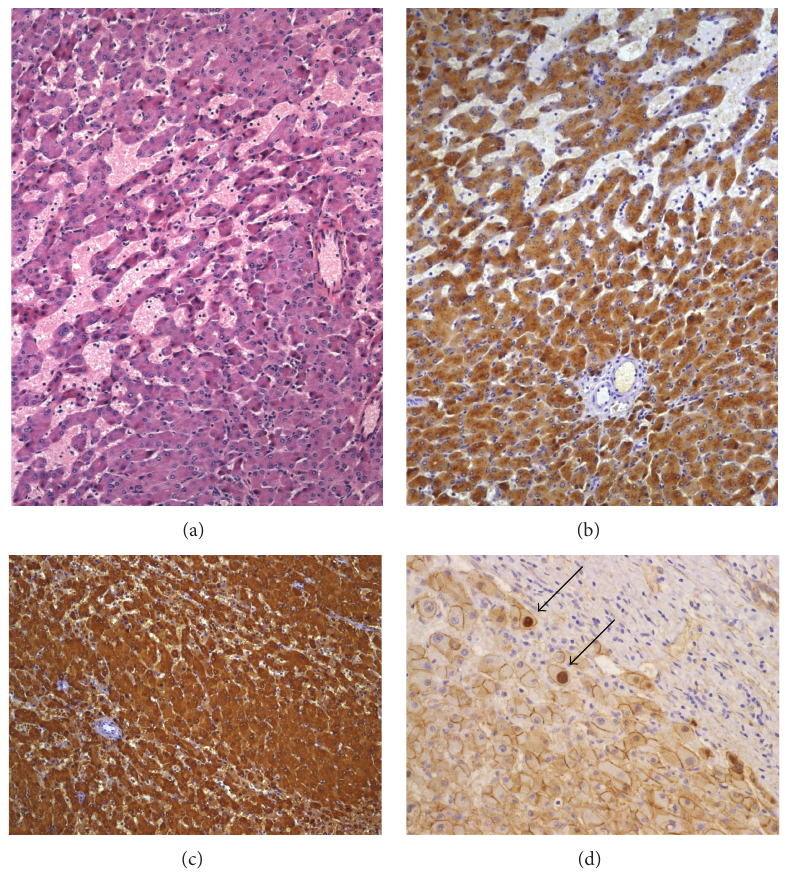
Figure 2: 𝛽 -catenin-activated/inflammatory HCA ((a), Obj × 5) with strong SAA ((b), Obj × 5), and GS ((c), Obj × 5) staining showing focal nuclear 𝛽 -catenin staining indicated by arrows ((d), Obj × 20).